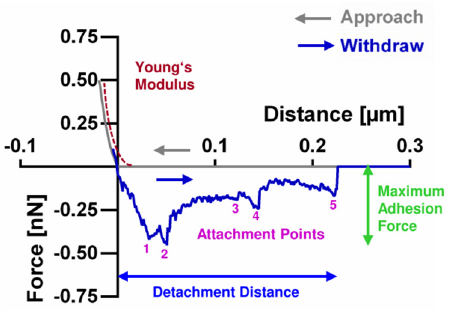
Figure 1. Schematic illustration of parameters quantified from force–distance curves of single-cell force spectroscopy. The grey curve shows the approach of a bacterium to the surface, whereas the blue curve shows its subsequent withdrawal.